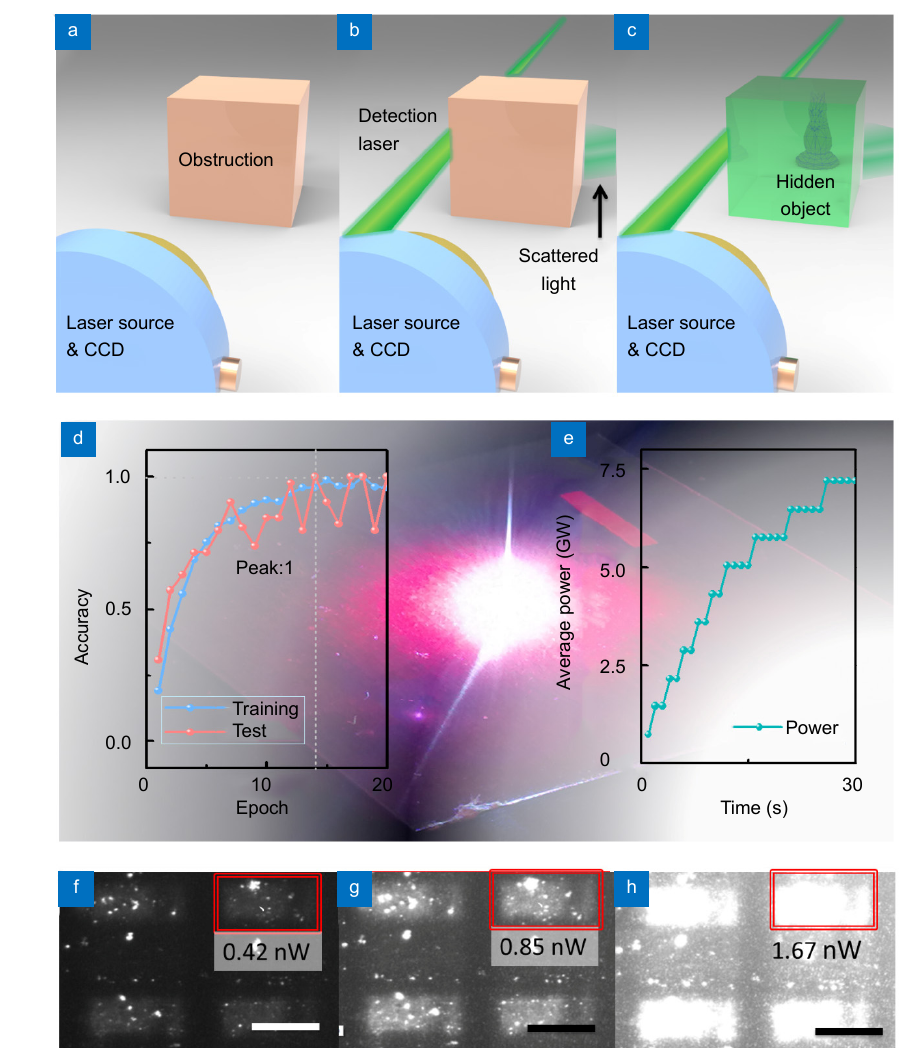
Fig. 4 | Applications of the inverse sensing. ( a – c ) Illustration of detecting the light which “goes through the wall”. ( a ) The object is completed hidden from the sight of the conventional detector. ( b ) The scattered photon from the detection laser reveals information of the hidden object. ( c ) The analysis of the scattered photon re-constructs and identifies the hidden object. ( d , e ) Dynamic monitoring of the high energy pulsed laser intensity. ( d ) Accuracy of the CNN DL after each training epoch for the dynamic laser ablation monitoring. ( e ) Monitoring of the laser intensity at the focal spot during the laser fabrication. ( f – h ) Light emission intensity characterization of the fluorescence molecules. Optical image of the Rhodamine B patterns irradiated by 532 nm pumping light at different intensities (from left to right: 8, 16, and 29 mW, respectively, scale bar: 50 μ